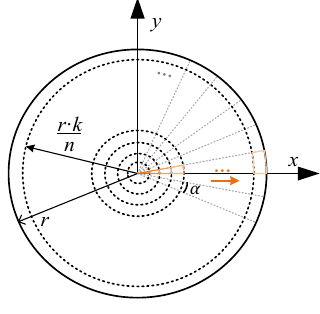
Figure 3. Schematic diagram of the observation plane division.